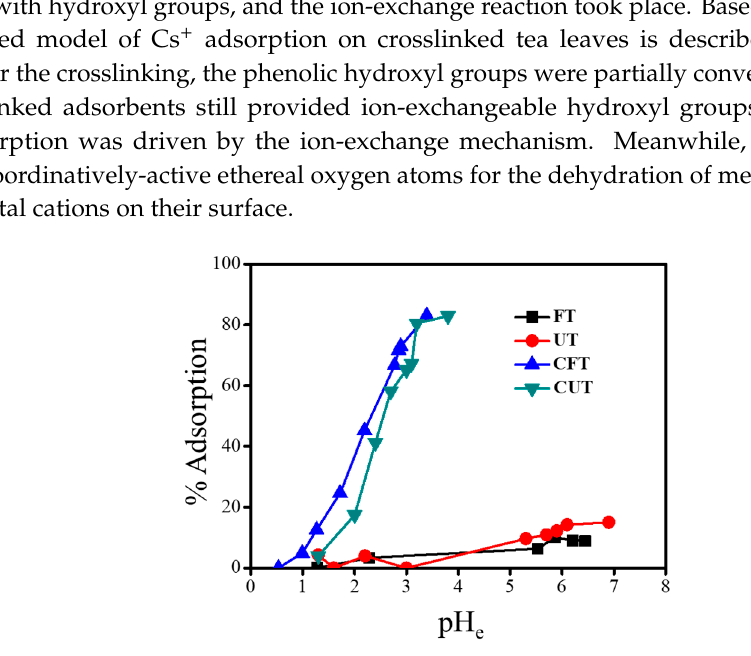
Figure 2. Adsorption of Cs + ions on crude and crosslinked tea leaves as a function of equilibrium pH, adsorbent weight = 0.05 g, solution volume = 10.0 cm 3 , [Cs + ] i = 1.0 mM, shaking time = 24 h.